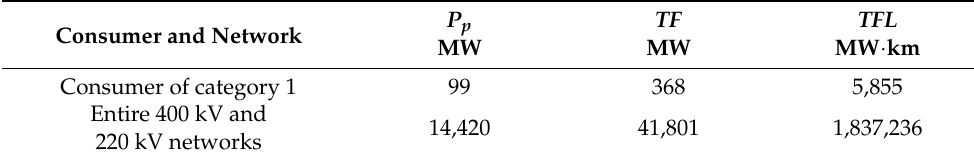
Table 8. The peak power and the degree of network utilization by the consumer of category 1. P p TF Consumer and Network